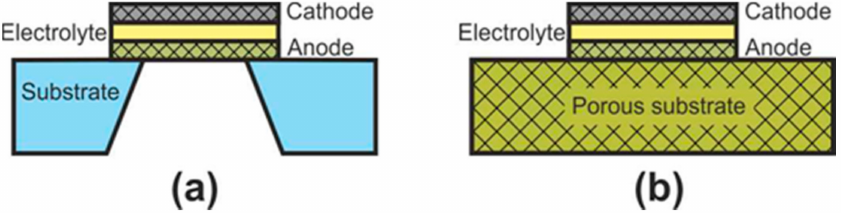
Figure 7. Schematics of ( a ) free-standing FT-SOFC and ( b ) porous substrate supported